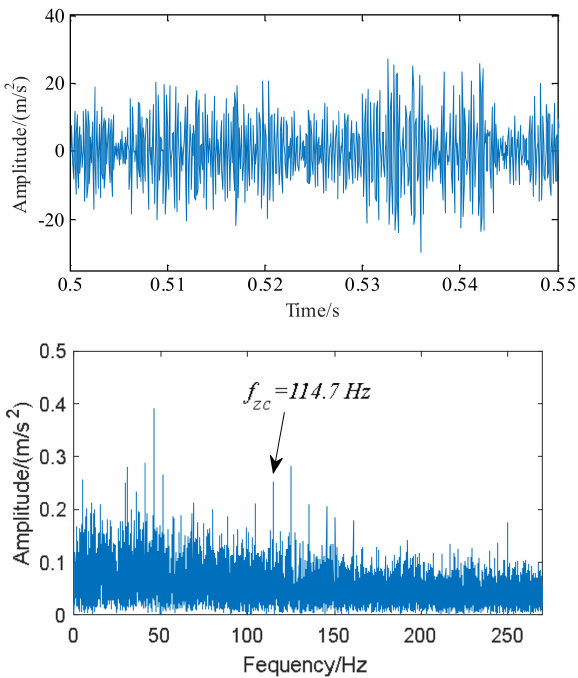
Figure 12. Time–domain signal and envelope spectrum of the normal state (experimental). (2) Simulation of the Inter-Shaft Bearing with OR Fault Set the OR rotating speed of the inter-shaft bearing at 300 r/min and the IR speed at 1500 r/min. According to the empirical formula of FCF, the FCF of the OR fault is obtained as shown in Table